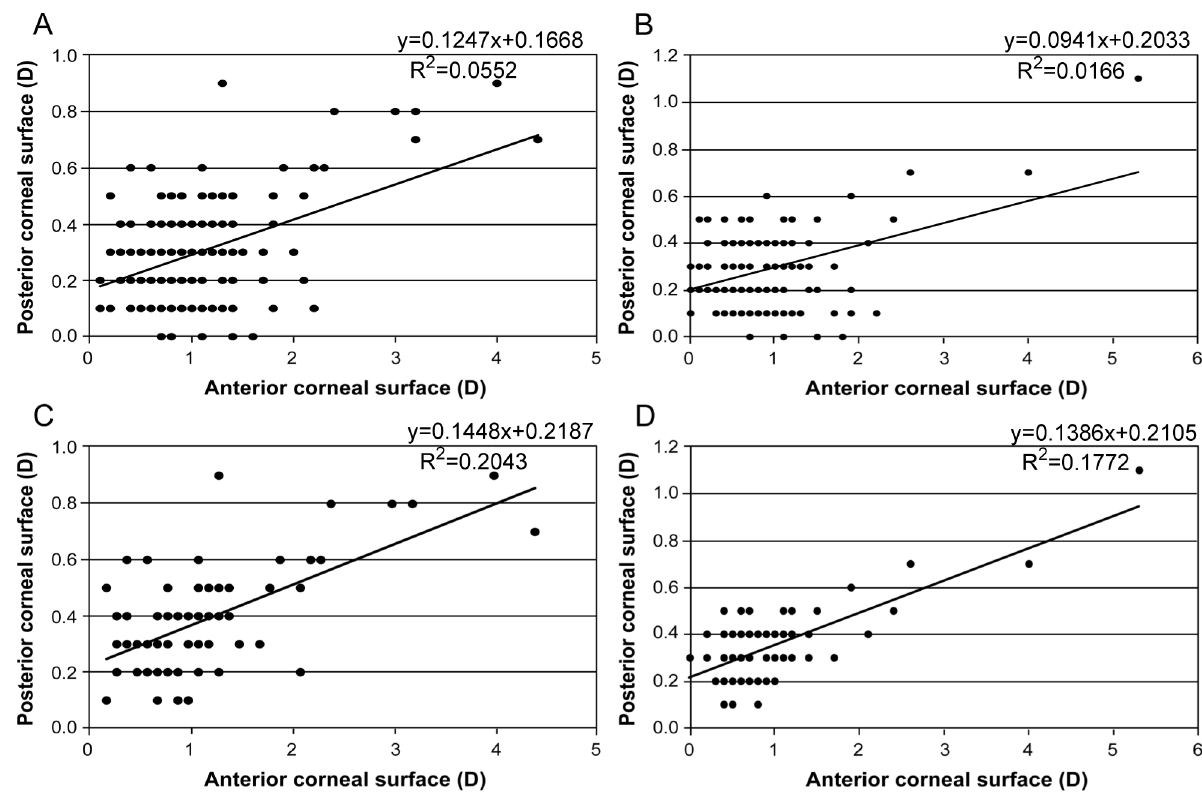
Fig 1. Correlation of the magnitude of astigmatism between posterior corneal surface and anterior corneal surface. A: high- myopia group (r = 0.235, p = 0.002), B: control group (r = 0.129, p = 0.115), C: anterior corneal surface with WTR astigmatism in the high- myopia group (r = 0.452, p = 0.000), D: anterior corneal surface with WTR astigmatism in the control group (r = 0.421, p =